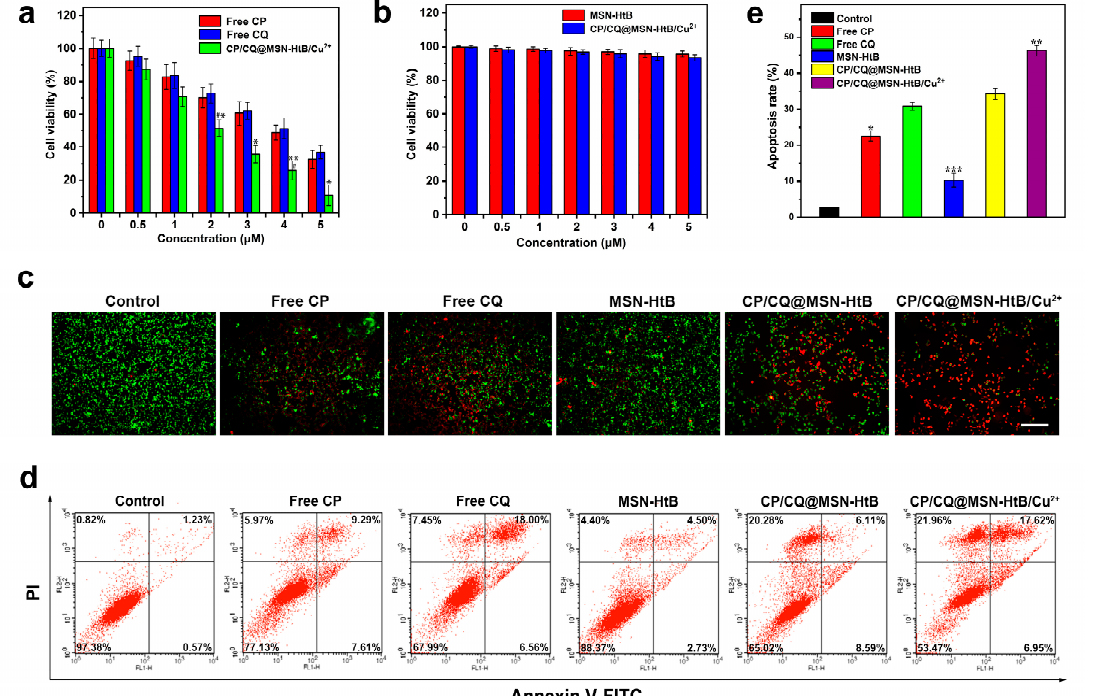
Figure 4. Cell viability of ( a ) B16 cells and ( b ) L-929 cells after incubation with MSN − HtB and CP/CQ@MSN − HtB/Cu 2+ NPs for 24 h. ( c ) Fluorescence images of B16 cells co-stained with calcein AM/PI after different treatments. Scale bar: 100 µ m. ( d ) Flow cytometry analysis using annexin V– FITC/PI staining, and ( e ) statistical analysis (results are presented as mean ± SD, n = 3). (* p < 0.05, ** p < 0.01, *** p < 0.001, compared with free CQ; # p < 0.05, compared with free CP).